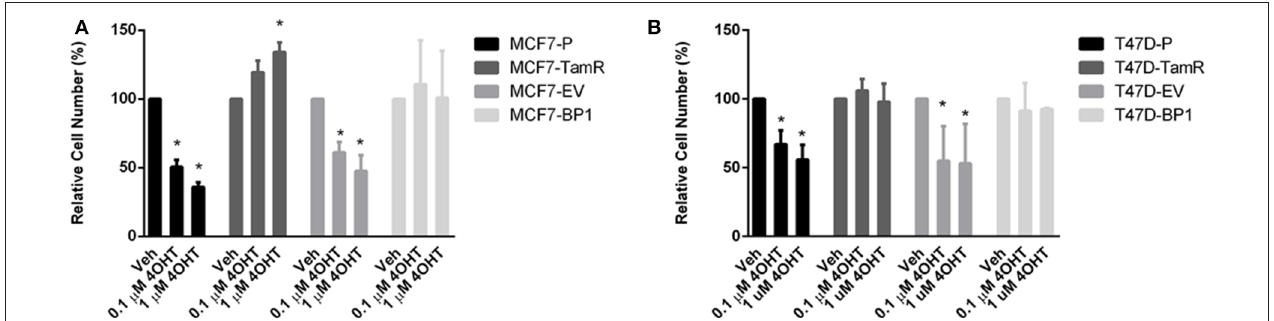
FIGURE 4 | Sustained IGFBP-1 exposure results in the development of tamoxifen resistance in breast cancer cells. (A) Measurement of relative cell number (%) in four different MCF-7 cell lines under 4-hydroxytamoxifen (4OHT) treatment for 5 days. (B) Measurement of relative cell number (%) in four different T-47D cell lines